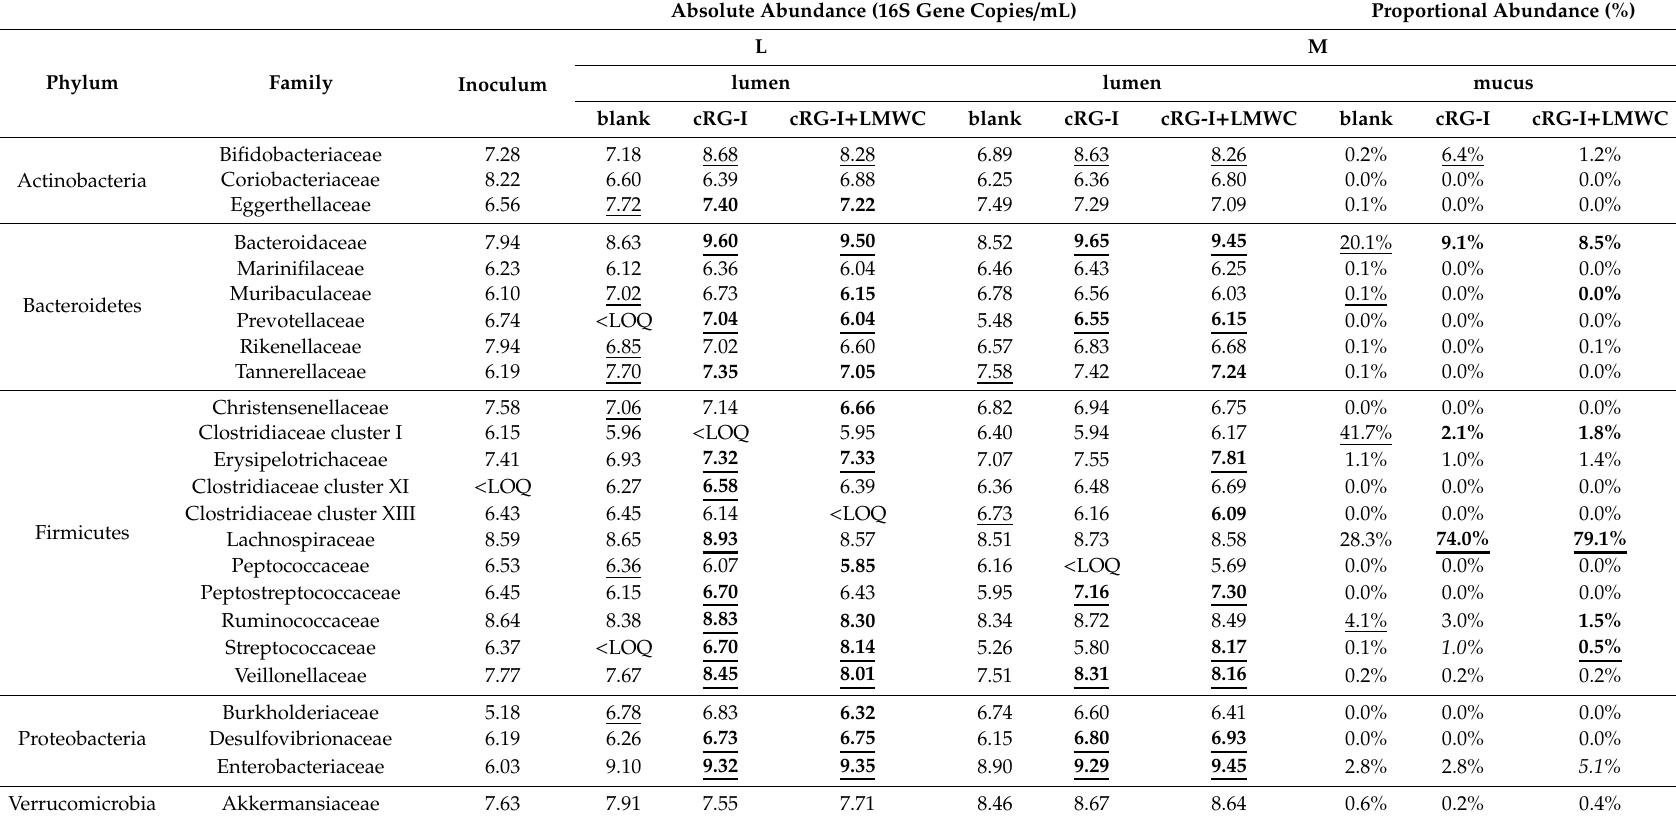
Table 1. E ff ect of fermentation of cRG-I and cRG-I + LMWC on microbial composition at family level in short-term colonic incubations in absence or presence of a mucosal compartment. Average proportional (%) (mucus) and absolute (16S gene copies / mL) (lumen) abundance of the di ff erent bacterial families in the original (diluted) inoculum and after 48 h of incubation upon dosing cRG-I and cRG-I + LMWC versus a blank control ( n = 3). Statistically significant di ff erences between the blank and treatments are indicated in bold ( p < 0.05). Upon reaching statistically significant di ff erences, highest values are underlined. Values indicated in italicsy are strongly increased, although not significant. L = colonic incubations only simulating lumen; M = incubations simulating both lumen and